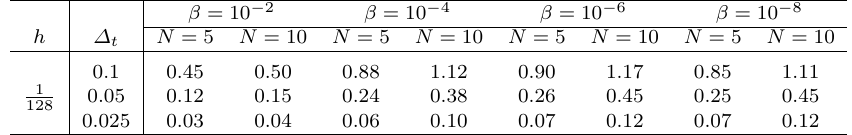
Table 4. Problem 1: Difference between the optimal control solution u opt and the solution from the time stepping method u k for t k = T β = 10 − 2 β = 10 − 4 h ∆